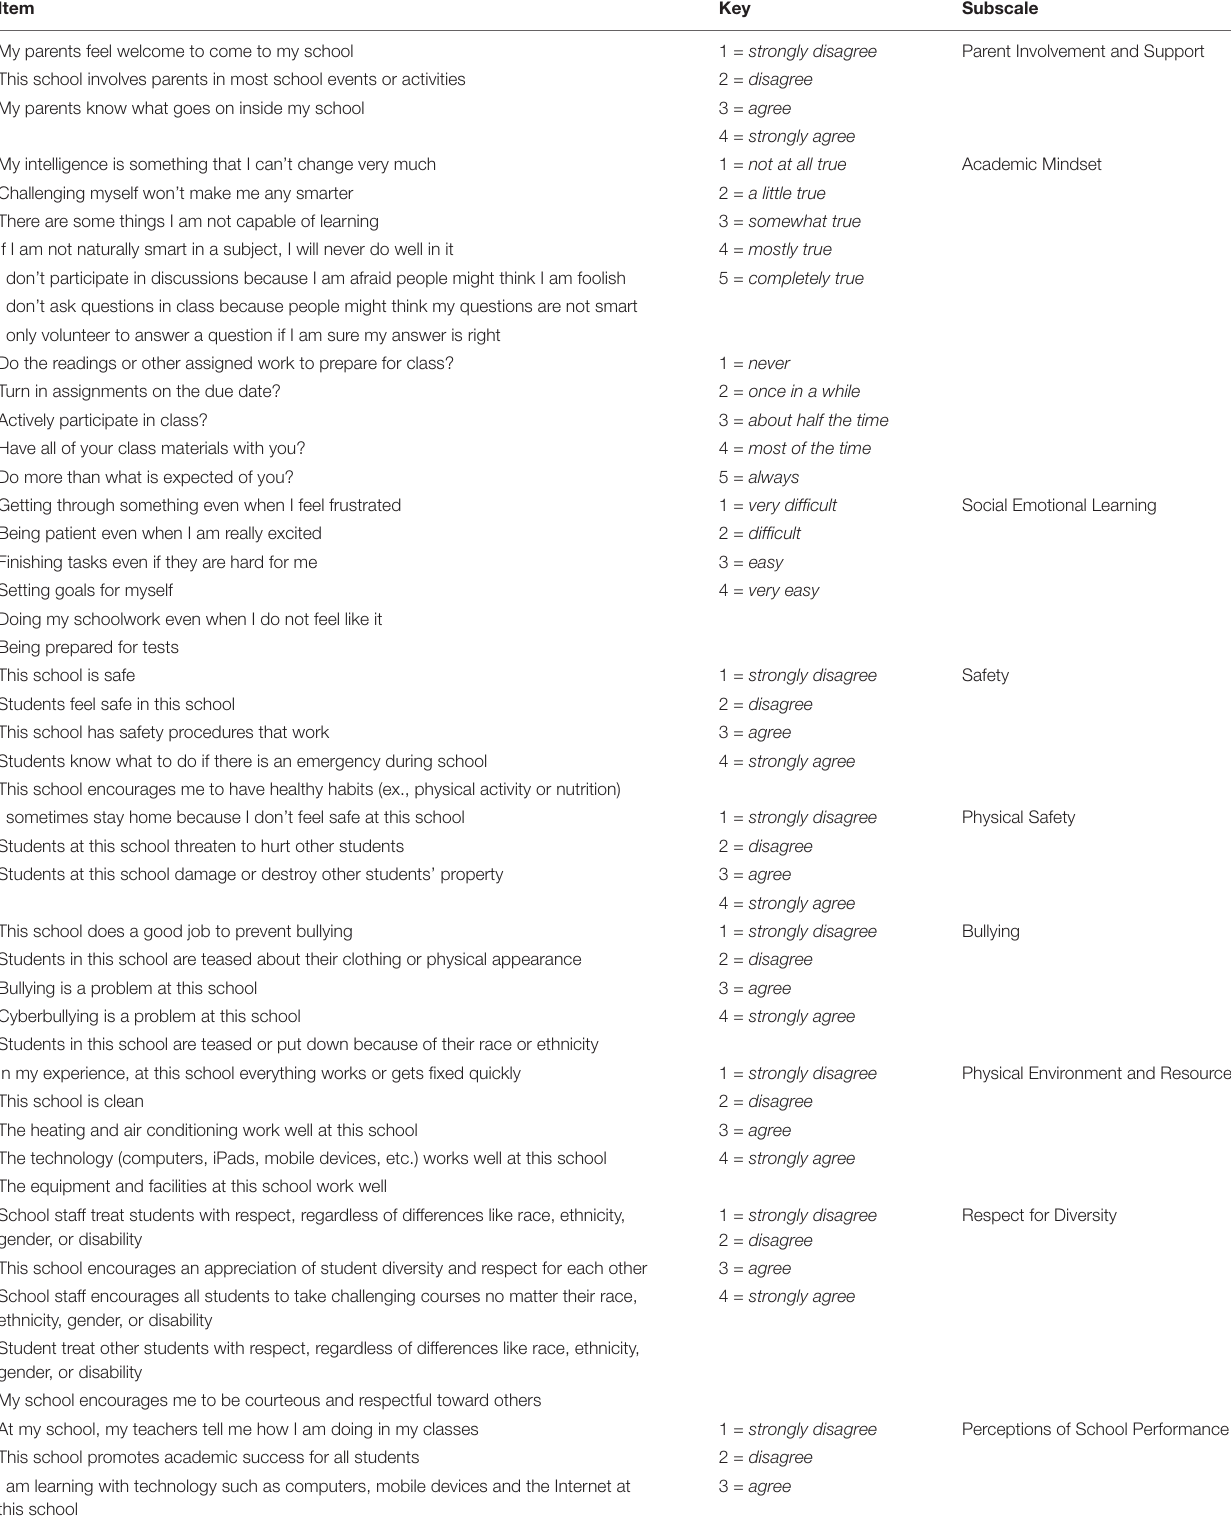
TABLE 2 | School Climate and Academic Mindset Inventory items (trimmed model).